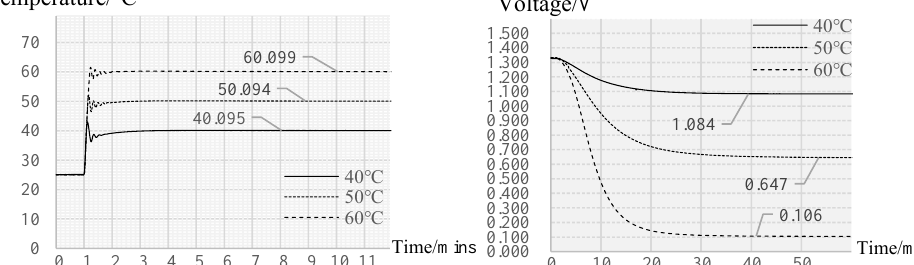
Figure 15. Measurement of the thermistor ( left ) and the voltage output by the photodetector ( right ). Figure 15 (right) shows the following: (1) when the temperature is controlled at 25 ◦ C (t1), the output voltage of photodetector remains stable at about V1 and fluctuates within ∆ V1; (2) the heating system starts to work, and the measured temperature of the vapor cell rises to the set value (t2), after which, about 10 minutes, the temperature measurement value of the system output becomes stable and the fluctuation range is less than 0.1 ◦ C; (3) in about 40 min, the output voltage of the photodetector is stable at V2 and fluctuates within ∆ V2, and the heat transfer between the non-magnetic alloy and the atomic vapor is almost in equilibrium. The temperature fluctuation range of the vapor ∆ t can be evaluated by Equation (9) (see Table 1). The testing results indicate that the fluctuation range of the vapor cell temperature is less than 0.018 ◦ C, 0.015 ◦ C, and 0.006 ◦ C, respectively, at 40 ◦ C, mins 50 ◦ C, and 60 ◦